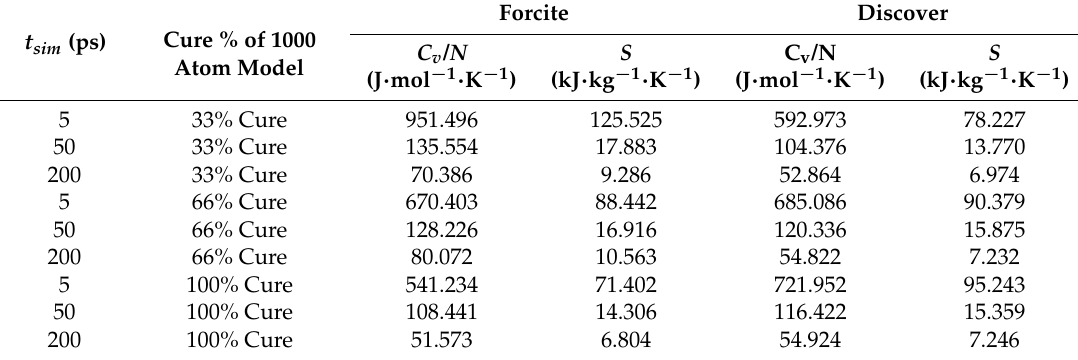
Table 2. Computed values of the heat capacity per atom ( C v /N ) and specific heat capacity ( S ) for the 48 RMD simulations of each of the models using the Nos é –Hoover thermostat in Discover and Forcite over 5, 50, and 200